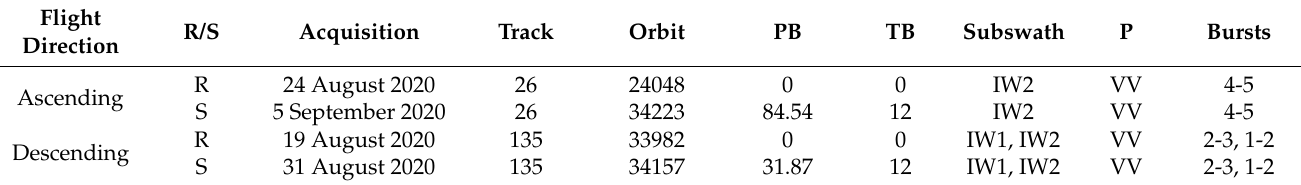
Table 2. Information on the Sentinel-1a